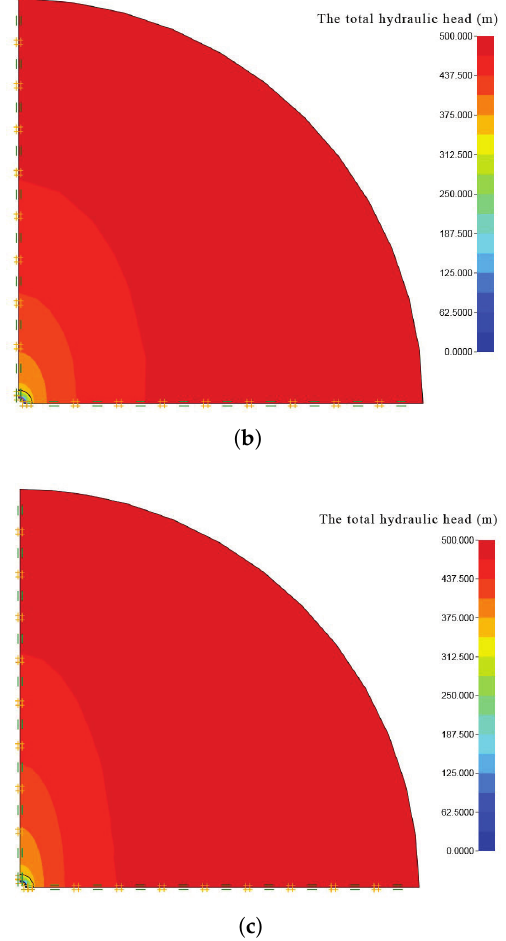
Figure 4. Total hydraulic head of lining structure, grouting ring and surrounding rock by numeri- cal simulation. ( a ) n = 1. ( b ) n = 2. ( c ) n = 3.